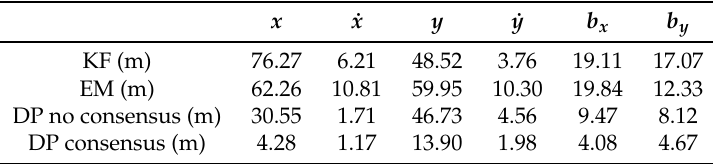
Table 4. Comparison of peak estimation error values.